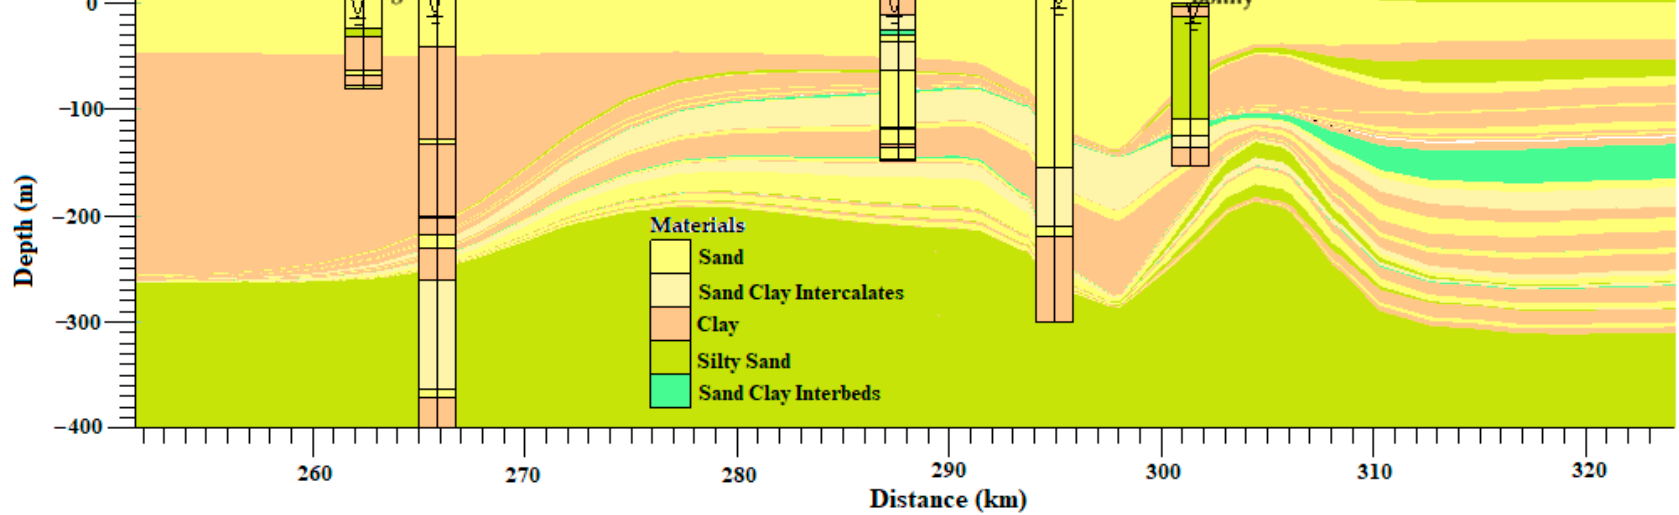
Figure 6. Hydrostratigraphic section along profile line DD I at various zones within the Niger Delta basin.